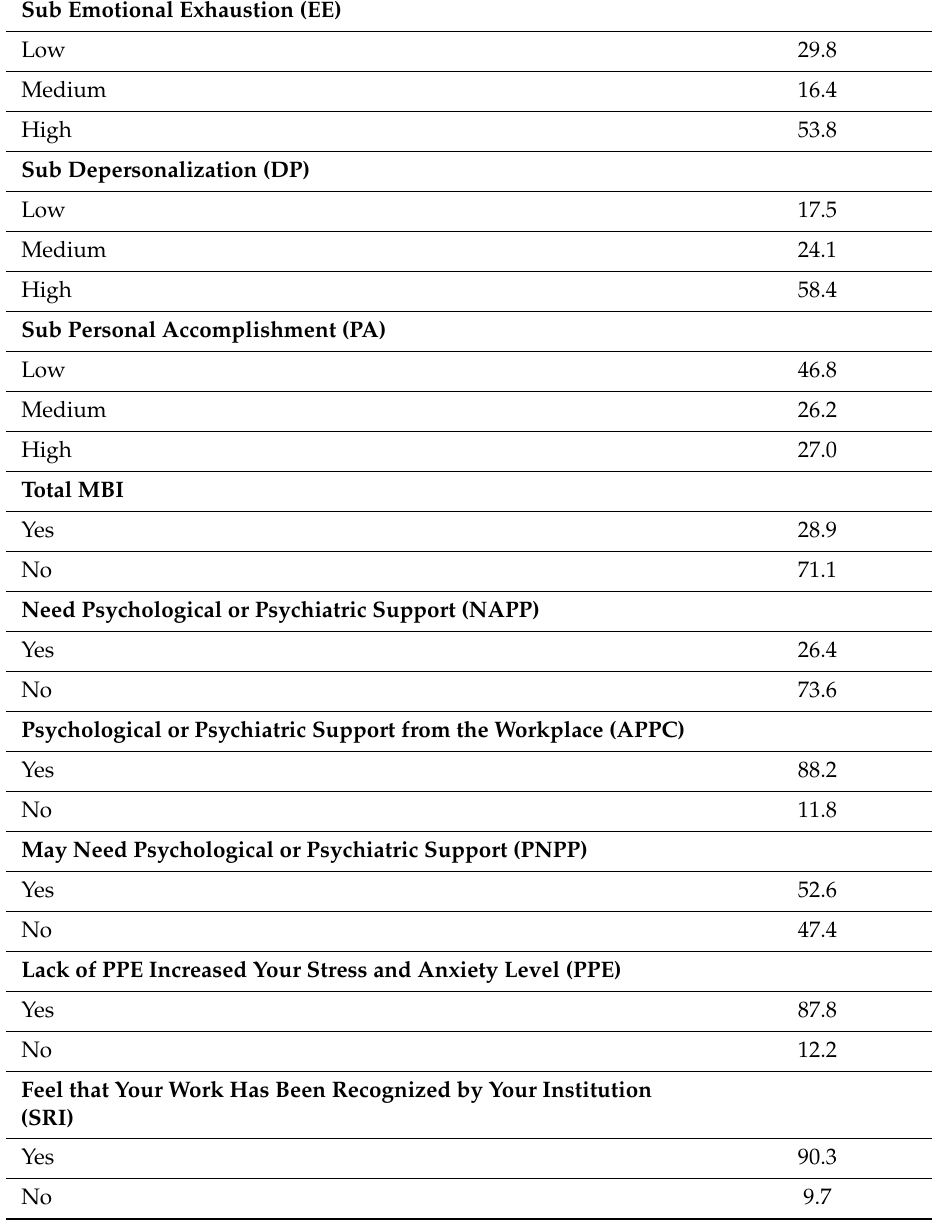
Table 2. Descriptive results of the independent